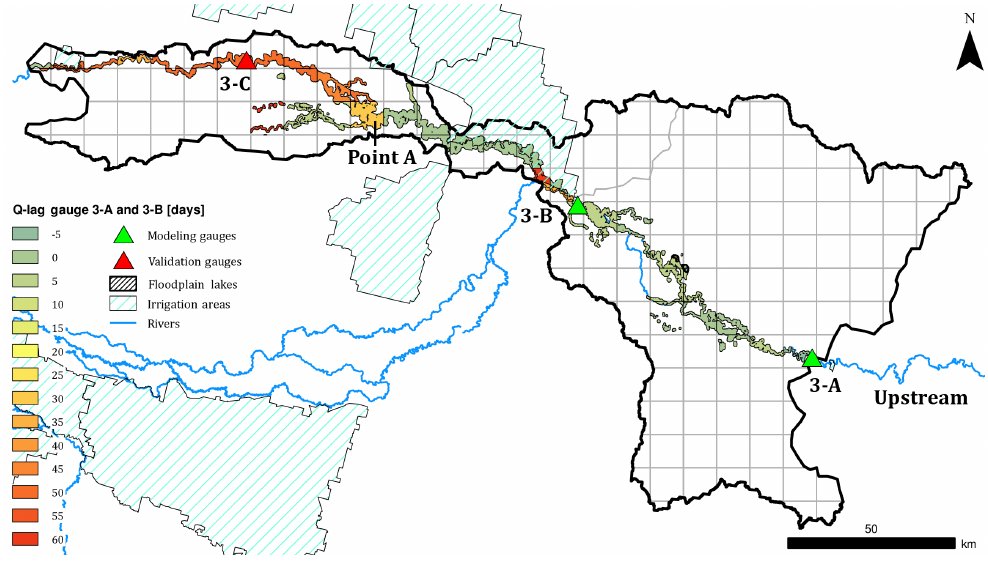
Figure 6. Model results of the Murrumbidgee sub-region: Q lags for river gauge 3-A (used for modeling the reach between gauge 3-A and 3-B) and 3-B (used for modeling all areas downstream of gauge 3-B). Table 6. Average CV-RMSE and r 2 of initial, base, and final models of the floodplain category of the three sub-regions (definition of initial, base, and final models is given in Sect.